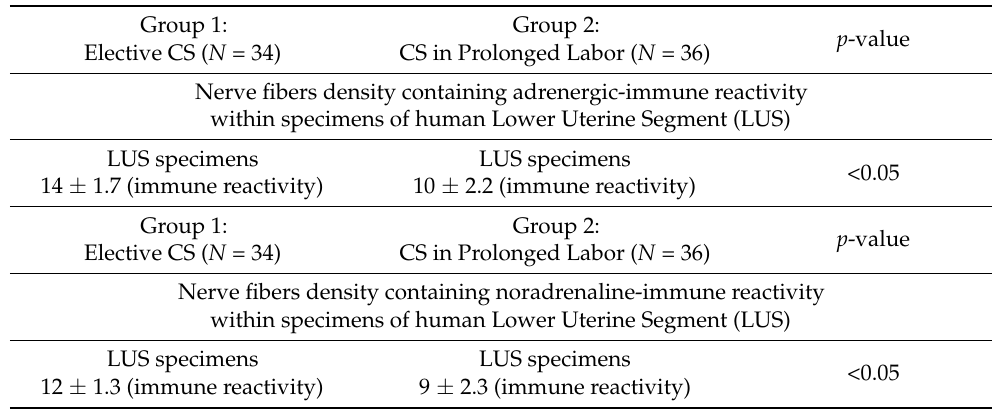
Table 2. Evaluation of A and N nerve fibers in lower uterine segment (LUS) in elective CS and on LUS of patients in prolonged labor submitted to